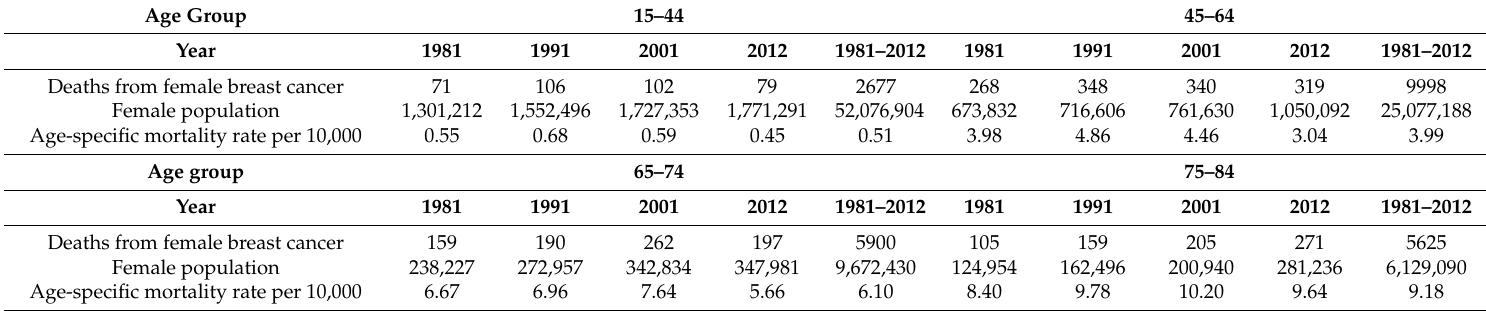
Table 2. Summary of mortality from female breast cancer in Andalusia (southern Spain) every ten years and for the full period (1981–2012), by age